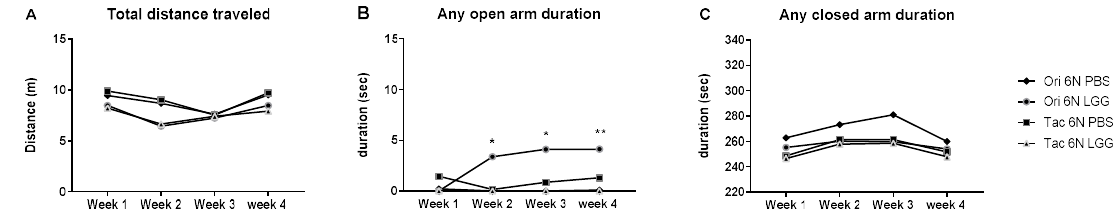
Figure 5. Modulation of the gut microbiota by probiotics can alter the anxiety. Probiotics reduced the anxiety levels of the experimental mice. Ori 6N PBS and Tac 6N PBS mice were both administered with 200 µL of PBS, while Ori 6N LGG and Tac 6N LGG mice both received 200 µL of Lactobacillus rhamnosus GG (LGG) twice a day for four weeks. Each group comprised 7 animals. ( A ) The total distance traveled on the elevated plus maze in each week; ( B ) Time spent on any of the open arms; ( C ) Time spent on any of the closed arms. The data are represented by the means and were analyzed by Fisher’s LSD test and compared to the Ori 6N LGG group. Significance is indicated when * p < 0.05, and ** p < 0.01.